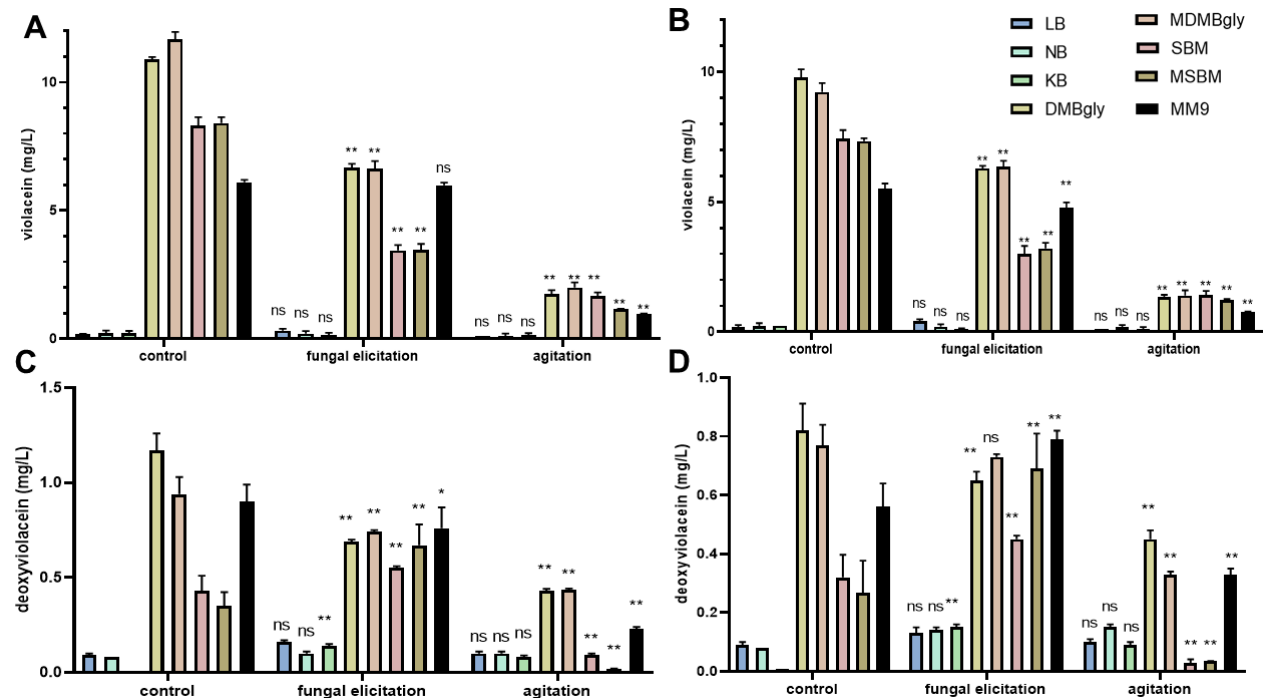
Figure 5. The effect of agitation and fungal elicitation on violacein and deoxyviolacein production in Janthinobacterium . The effect of agitation and fungal elicitation on violacein production in J. lividum ( A ) and J. agaricidamnosum ( B ). The effect of agitation and fungal elicitation on deoxyviolacein production in J. lividum ( C ) and J. agaricidamnosum ( D ). Violacein and deoxyviolacein were measured following 48 hours of fermentation in 5 L media, and the concentrations presented are the mean values of three independent replicates. Abbreviations: Luria – Bertani (LB), nutrient broth (NB), King’s B (KB), Davis minimal broth with glycerol (DMBgly), modified DMBgly (MDMBgly), Shipworm basal medium (SBM), modified SBM (MSBM). Note: * p ≤ 0.05; ** p ≤ 0.01; and ns: not-